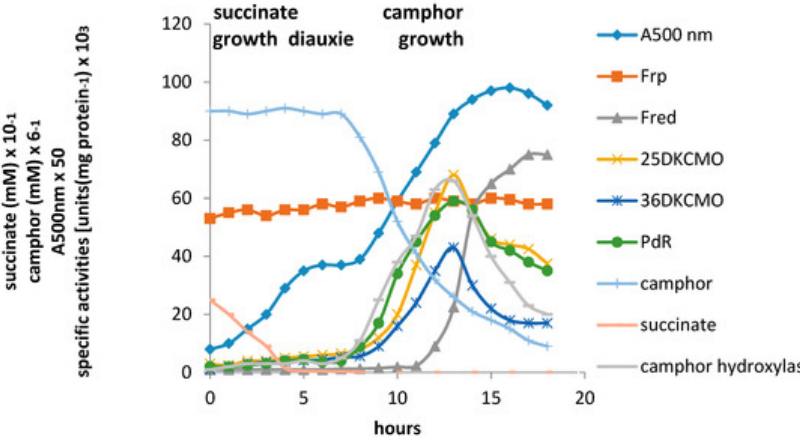
Figure 11. Changes in the optical density (A 500 nm), succinate (mM), ( rac )-camphor (mM), and the spe- cific activity of key enzymes of ( rac )-camphor degradation during diauxic growth of by P. putida ATCC 17453 on succinate plus ( rac )-camphor based defined medium. Camphor hydroxylase = camphor